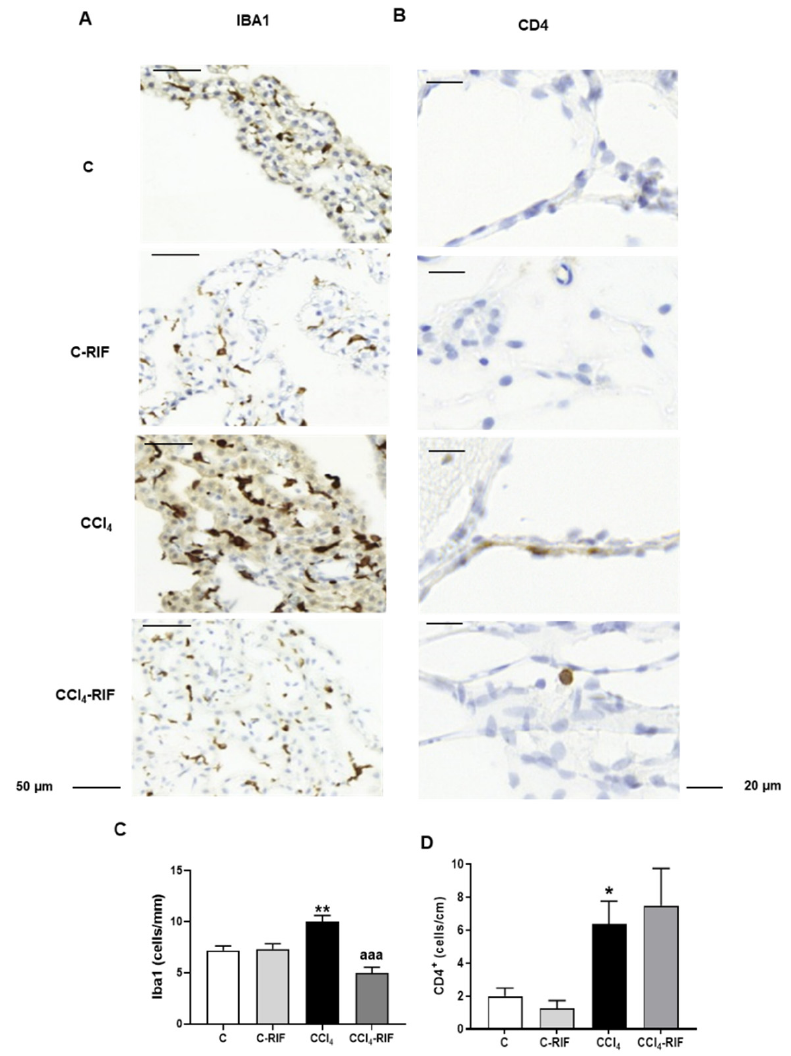
Figure 3. Infiltration of macrophages ( A ) and CD4+ T lymphocytes ( B ) into meninges of the hippocampus. It was analyzed by immunohistochemistry with anti-Iba1 or anti-CD4 markers, respectively. Values are the mean ± SEM of 5 rats per group. In ( C ) data were analyzed using one-way ANOVA and Tukey’s multiple comparisons test and in ( D ) using a Welch’s ANOVA test and Dunnett’s multiple comparisons test. The asterisks indicate a significant difference compared to the control group * p < 0.05, ** p < 0.01, and “a” significantly different from CCl 4 group, “aaa” p < 0.001.